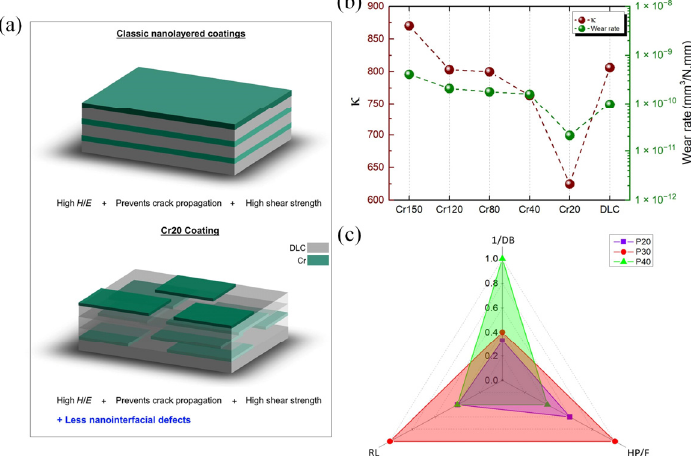
Figure 7. ( a ) Schematic diagram of the conventional multilayer coating and Cr20 coating; ( b ) relation between the wear rate and the proposed Ƙ parameter; ( c ) characteristics of the parameters affecting the tribological performance of the textured coating samples. Reprinted with permission from [107].